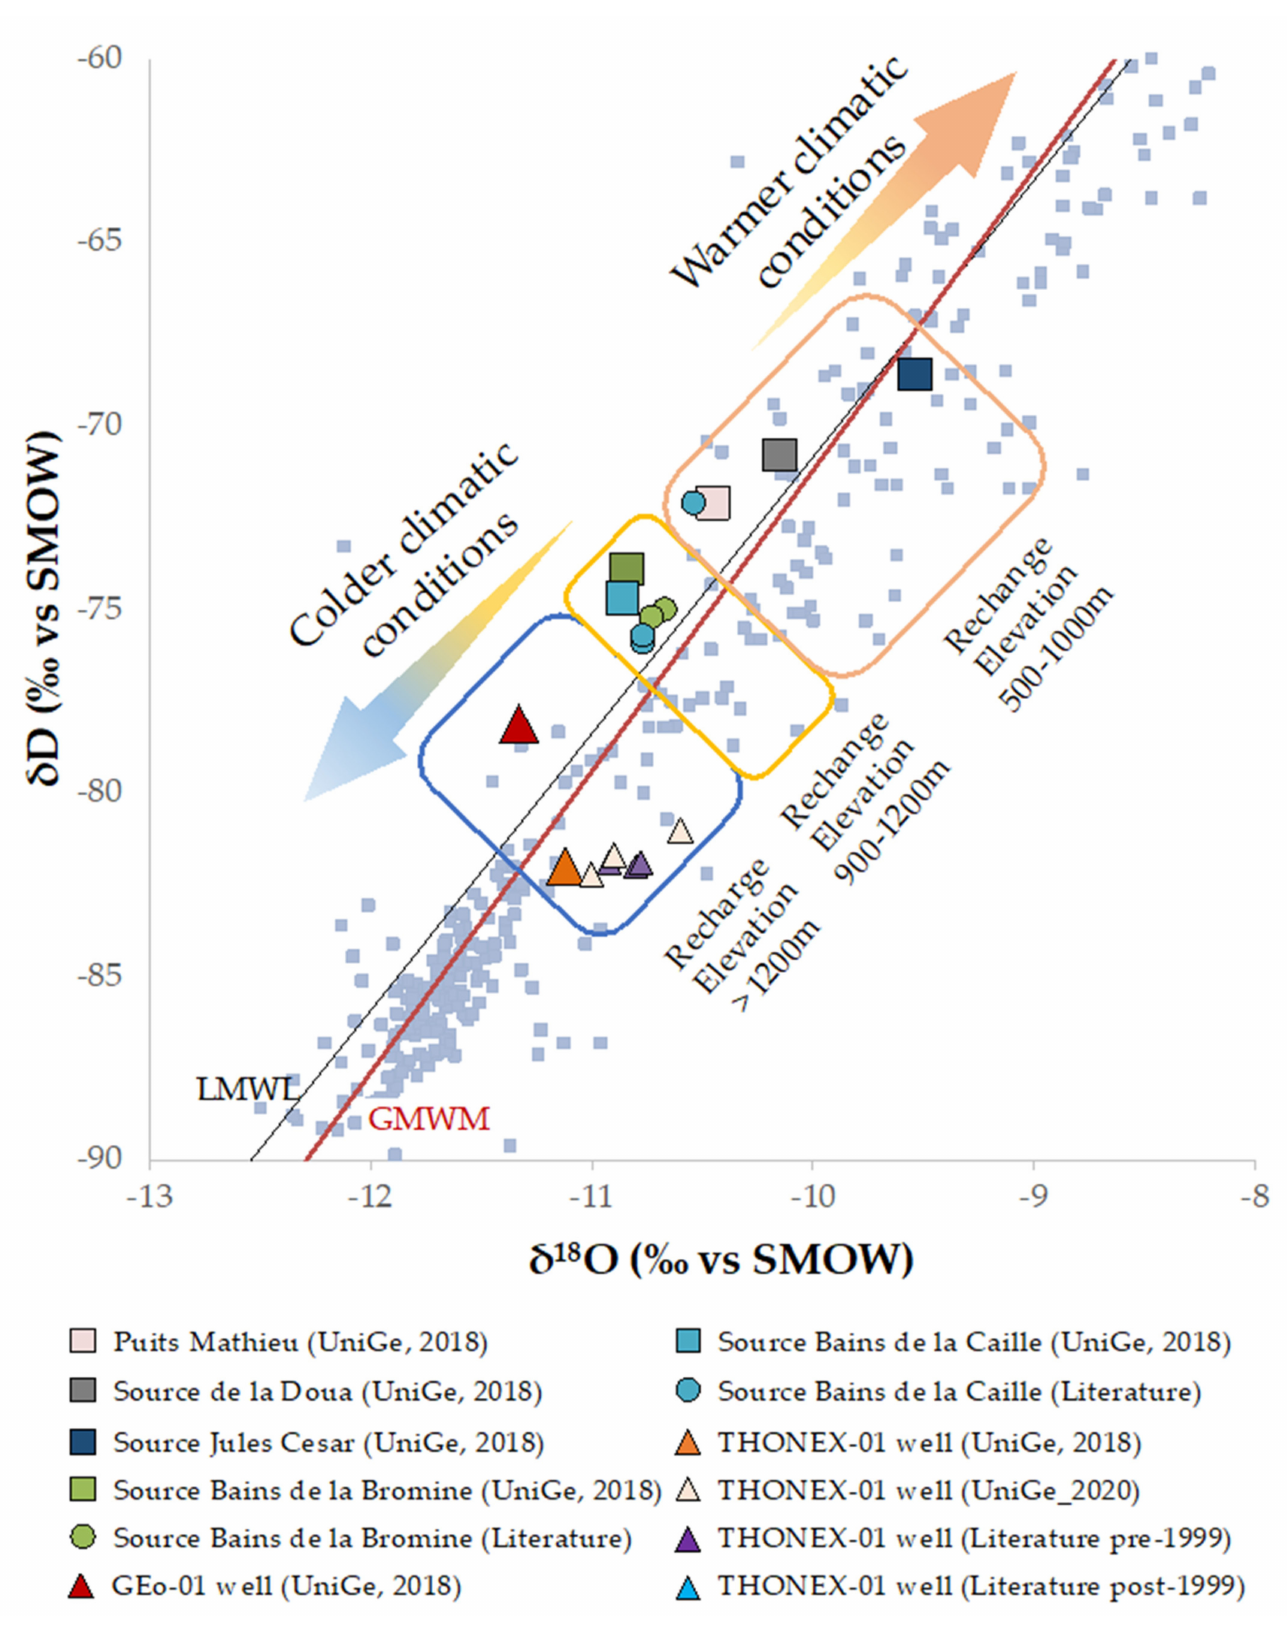
Figure 12. Stable Isotopes of Oxygen ( δ 18 O) and Hydrogen ( δ D) of the groundwaters in the Geneva Basin plotted against the data available from local weather